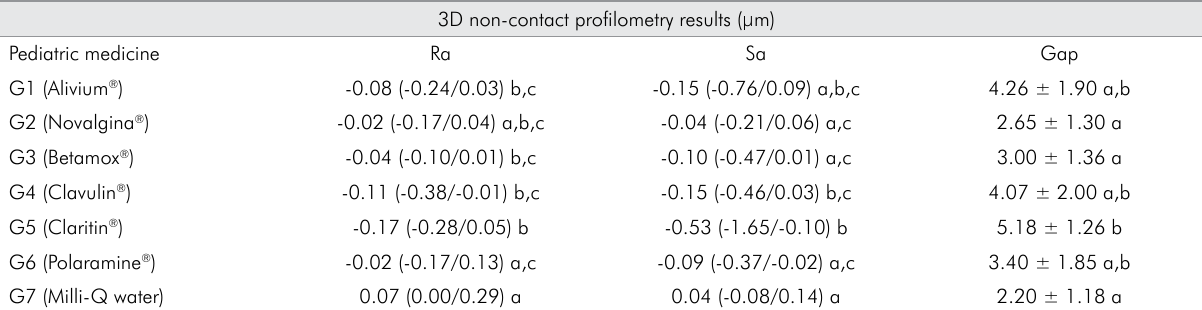
Table 2. Median (minimum/maximum value - μ m) of surface roughness (Ra and Sa) and Media ( μ m) of Gap ± standard deviation between the unexposed and exposed enamel surface of enamel specimen